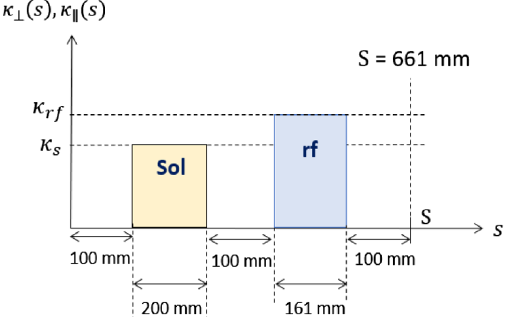
FIG. 1. Periodic focusing lattice composed of a solenoid and an rf cavity. The length of the lattice period is S ¼ 661 mm. Under solenoid focusing, axisymmetric beam propagation is possible along the linac.